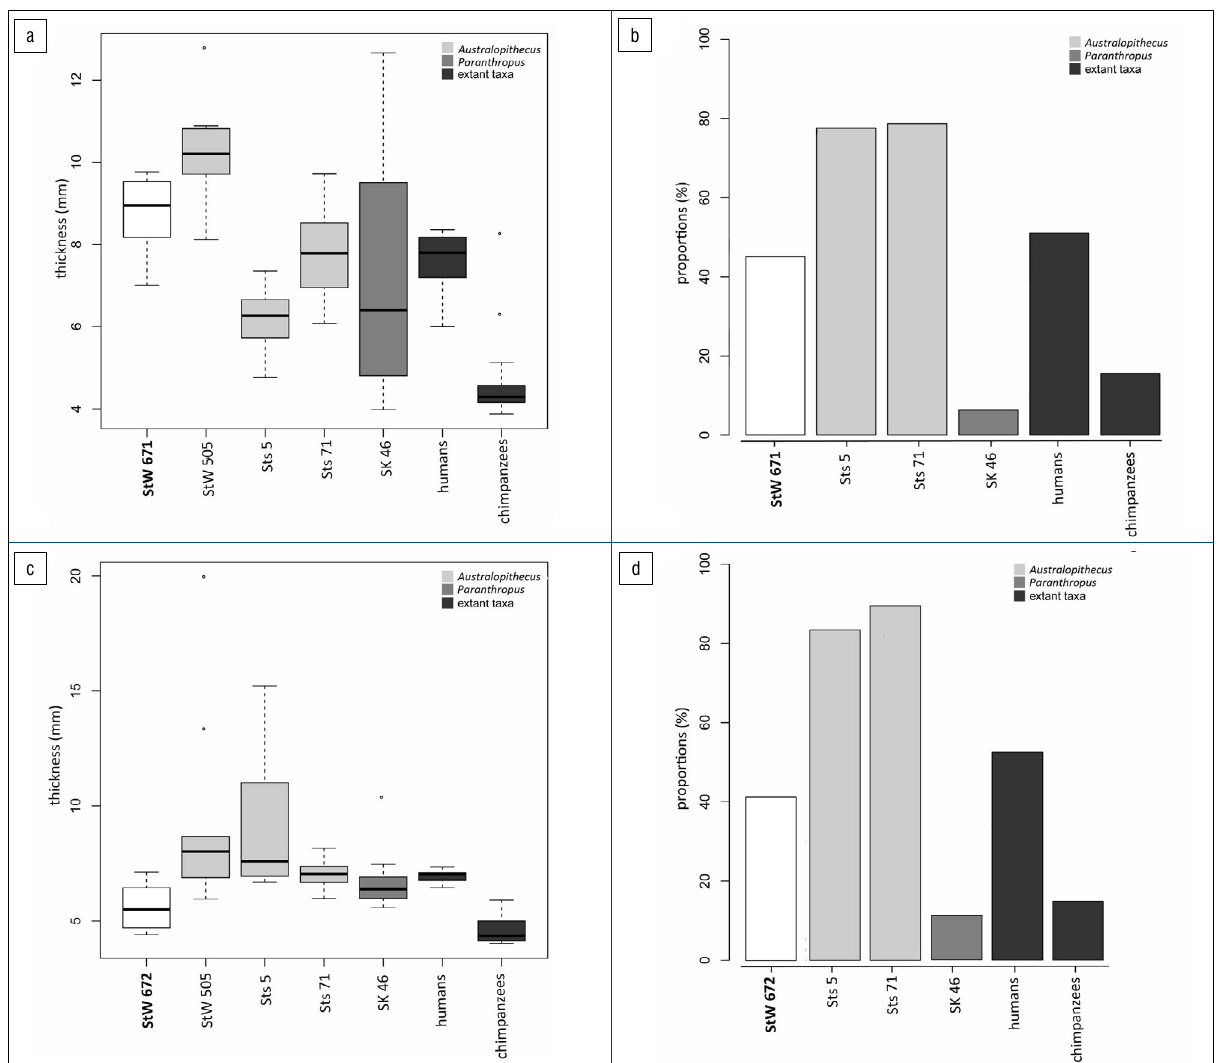
figure 4: (a and c) Box plots of cranial thickness and (b and d) histograms of proportion of diploë in (a, b) StW 671 and (c, d) StW 672 compared to some Plio-Pleistocene hominin specimens/taxa and extant human